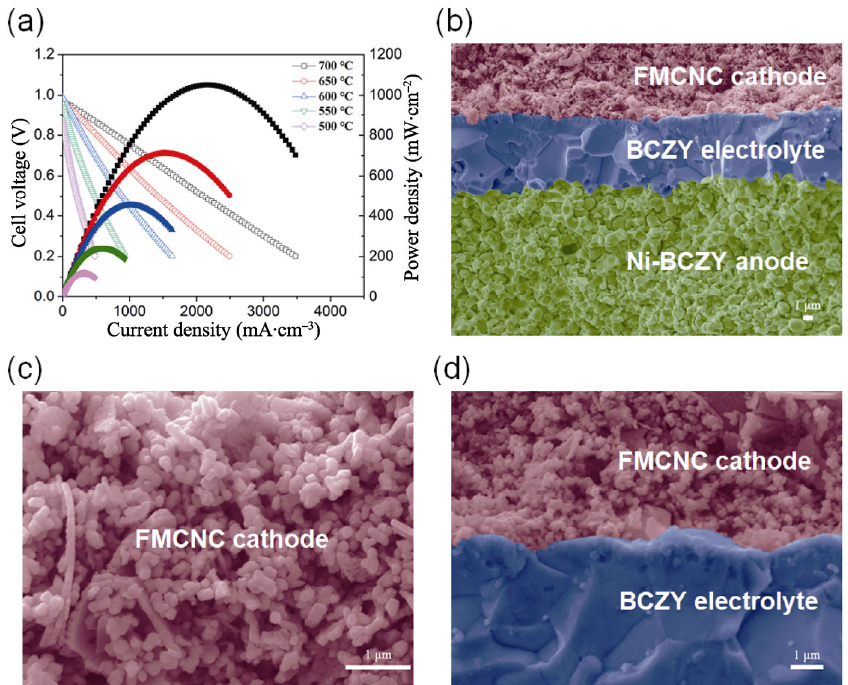
Fig. 5 (a) Cell voltage and power density vs. current density curves for FMCNC cell; SEM images of (b) FMCNC cell, (c) cathode, and (d) cathode–electrolyte